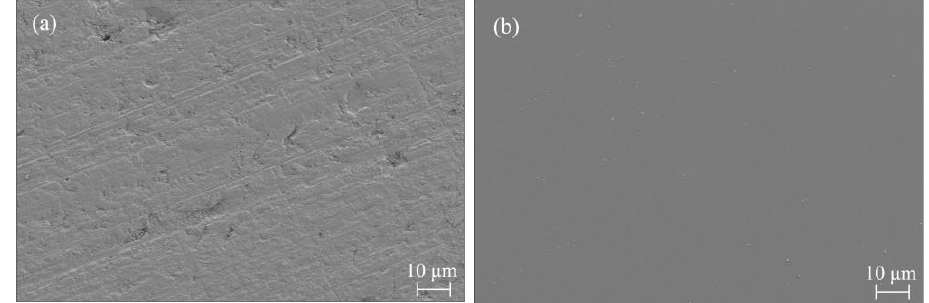
Figure 10. SEM micrographs of workpiece surface ( a ) before polishing and ( b ) after polishing.